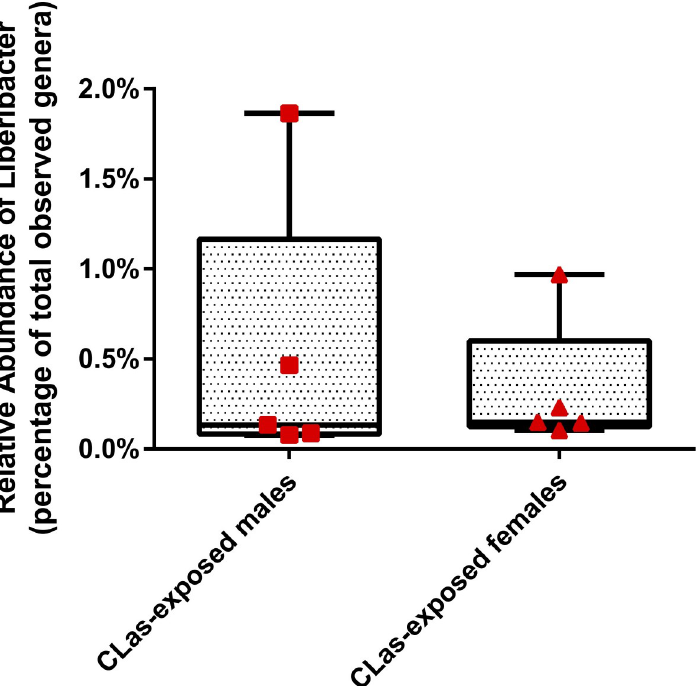
Fig 2. Liberibacter relative abundance in D . citri . The relative abundance of Liberibacter in 75-individual pooled CLas-exposed males and females was determined using 16S rRNA gene sequencing. A significant difference between median relative abundances of Liberibacter in CLas-exposed males and females was determined with Mann-Whitney U two-tailed test.